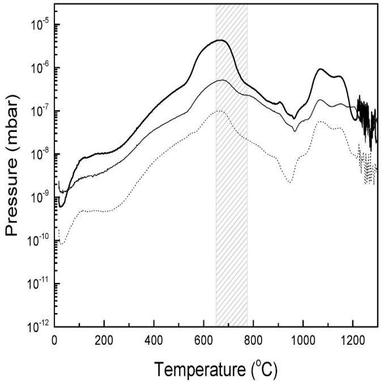
RGA traces of some CO2-associated peaks: m/z = 44 (CO2 +, thick solid line), m/z = 28 (CO+, thin solid line), and m/z = 12 (C+, dashed line). The shaded area denotes the thermal decomposition range of pure CaCO3 after Ref..